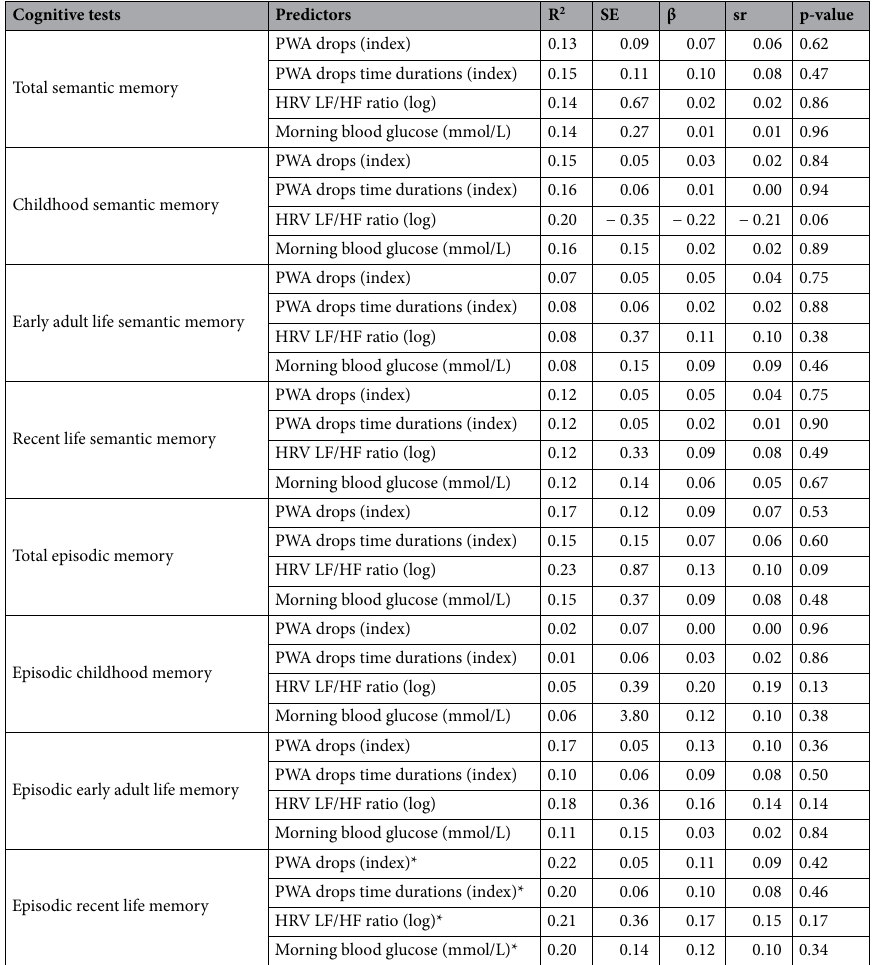
Table 6. Multiple linear regression analyses of the association between autobiographical memory interview indices and sympathetic nervous system activity indices. *Significant model (p < 0.05) after false discovery rate adjustment; The model was adjusted for demographic cofounders, hypoxia, sleep fragmentation and depressive symptoms; R 2 the models’ multiple correlations, SE standard error, β standardized regression coefficient, sr semi-partial correlation, log logarithmic